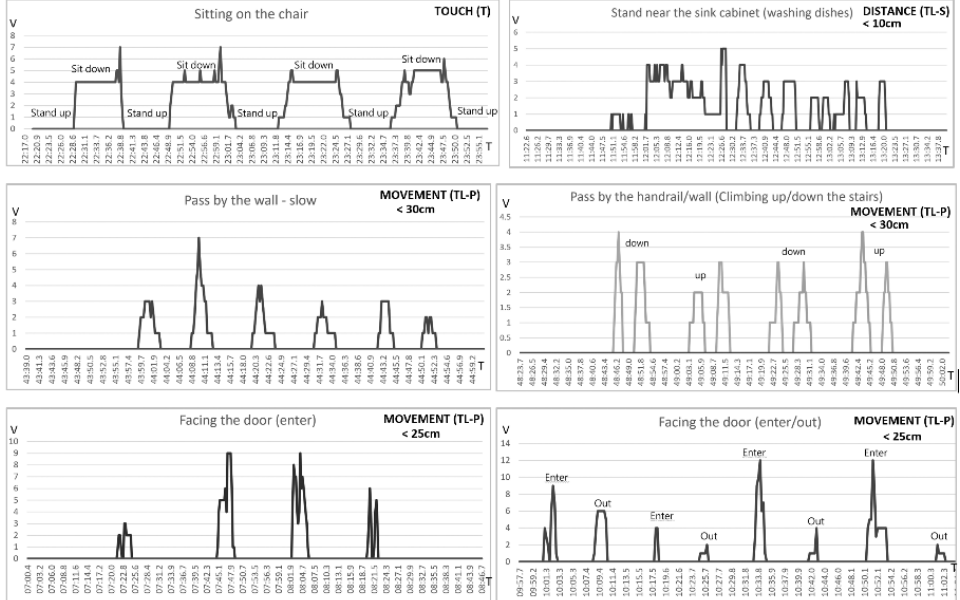
Figure 5. The sensing value patterns in different